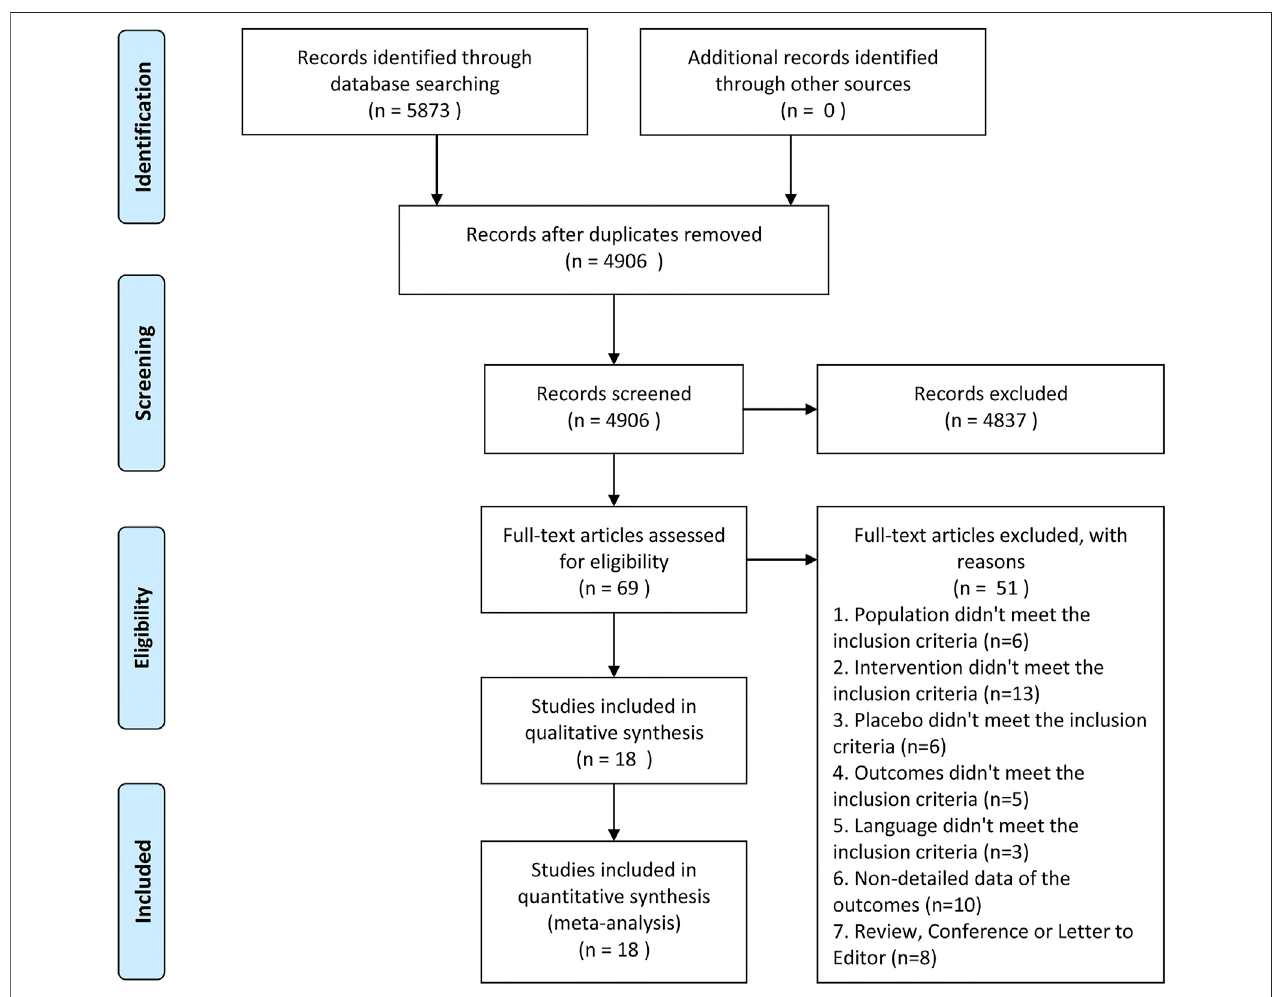
FIGURE 1 | Summary of trial identi fi cation and